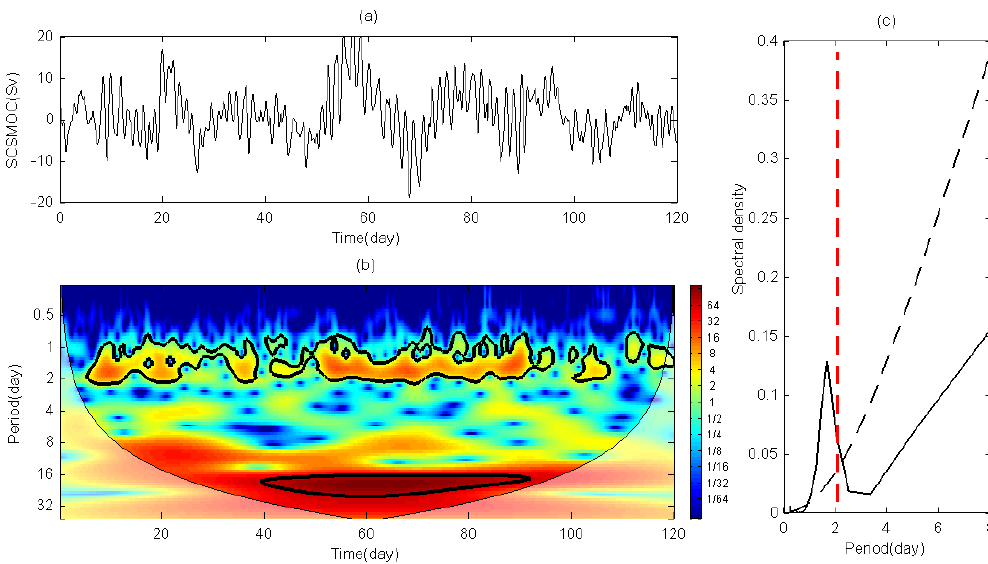
Figure 2. (a) Time series of SCSMOC at 1500m, 14 ◦ N; (b) the continuous wavelet power spectrum (black contours representing 95% sig- nificance); (c) the power spectrum (the dashed black line and red line show 95% confidence levels and the local inertial period,